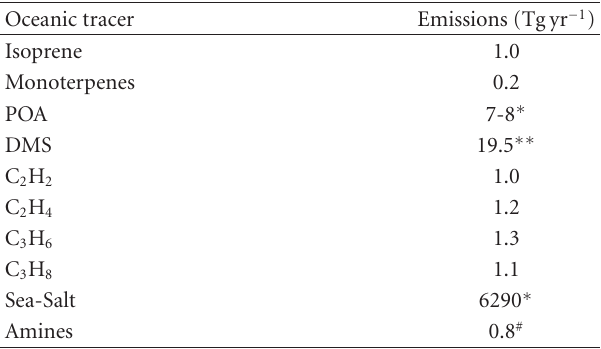
Table 1: Annual emissions of oceanic species adopted in the model. Oceanic